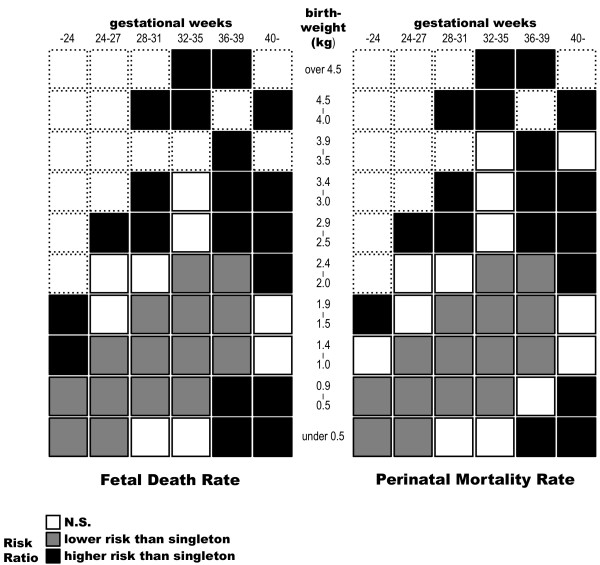
Twin/single risk ratio.